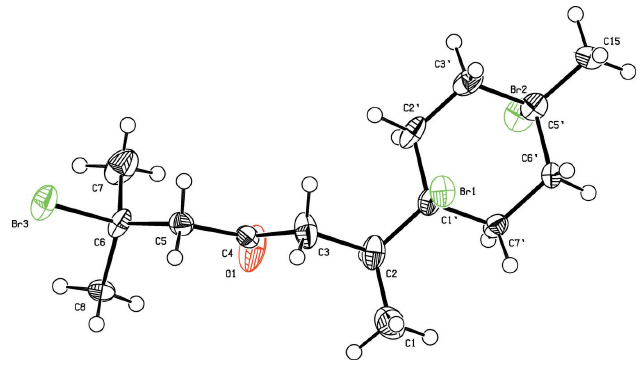
Figure 1 A view of the molecular structure of the molecule of the title compound, with atom labelling. Displacement ellipsoids are drawn at the 30% probability